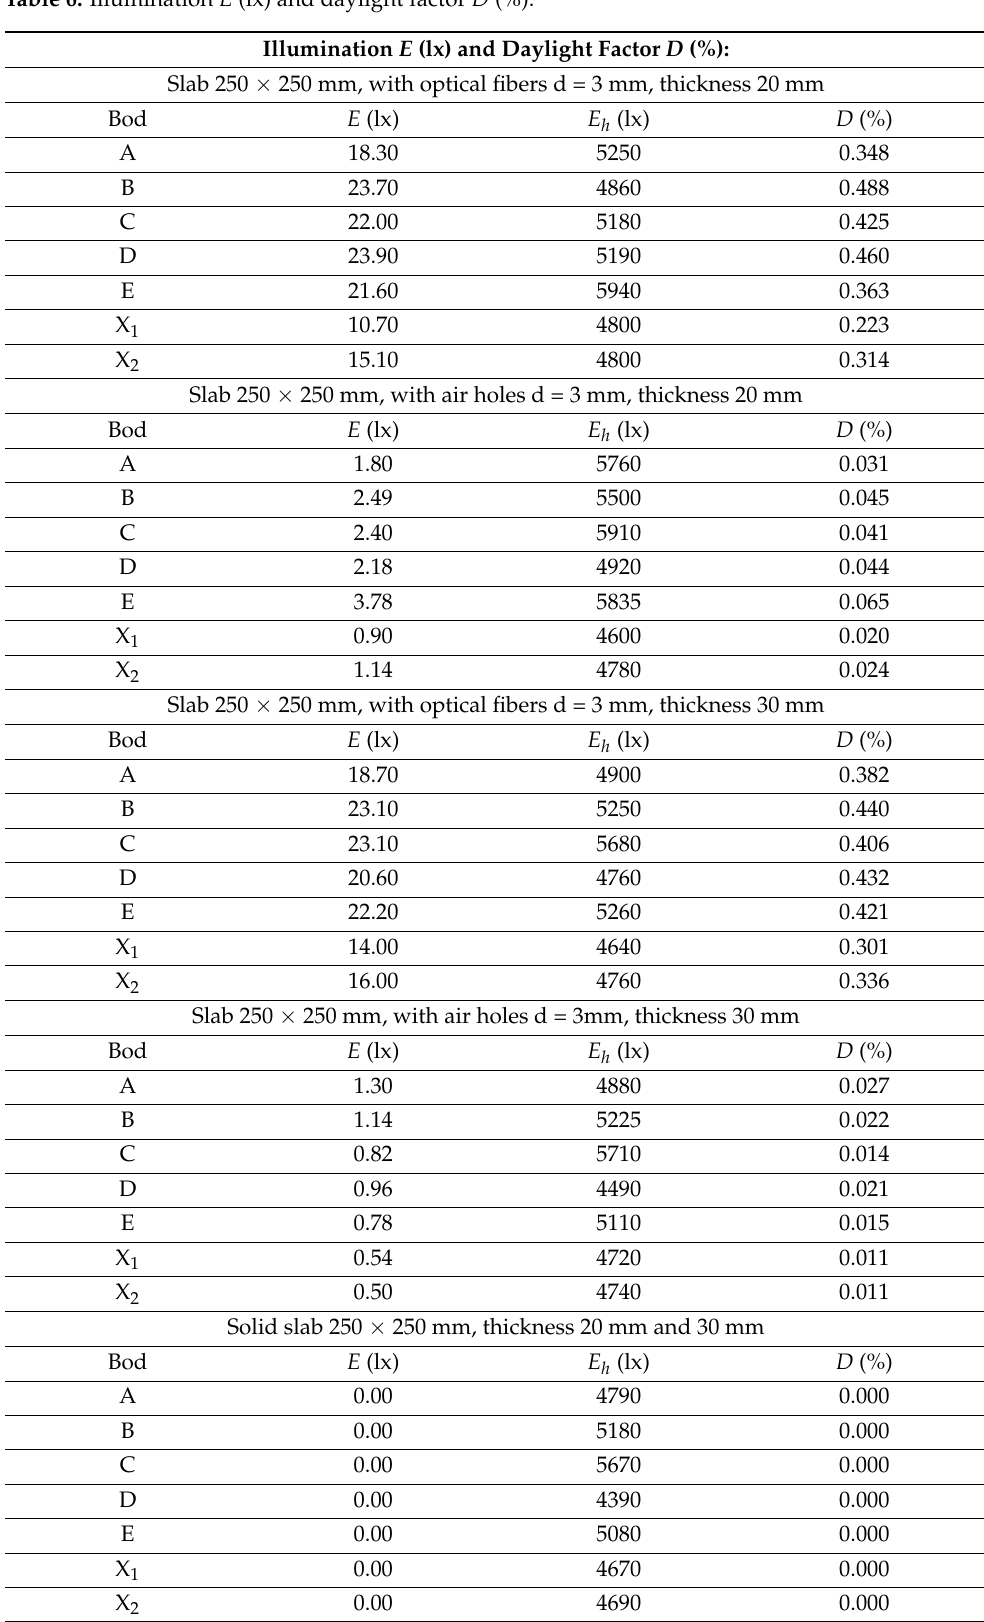
Table 6. Illumination E (lx) and daylight factor D (%). Illumination E (lx) and Daylight Factor D